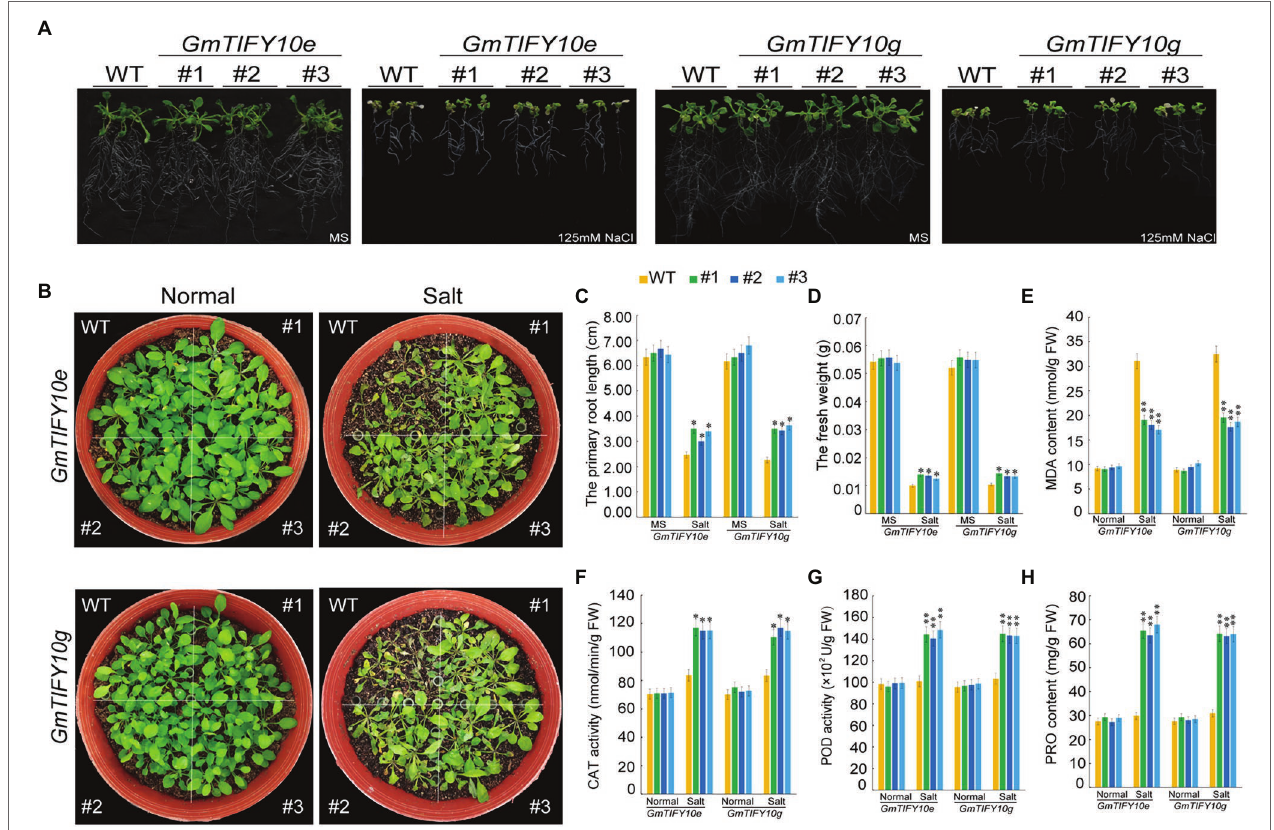
FIGURE 9 | Overexpression of GmTIFY10e and GmTIFY10g in Arabidopsis plants enhanced tolerance to salt stress. (A) Phenotypic analysis of transgenic Arabidopsis lines and WT lines under normal and 125 mM NaCl treatment. The scale bar indicates 2 cm. (B) Phenotypes of WT and transgenic plants under salt stress. (C) The primary root length analysis of the transgenic Arabidopsis lines and WT plants under normal and 125 mM NaCl treatment. (D) The fresh weights of transgenic Arabidopsis lines and WT lines under normal and 125 mM NaCl conditions. (E–H) The leaf contents of MDA (E) , CAT (F) , POD (G), and PRO (H) in WT and transgenic plants under normal and salt stress. The data are shown as the means ± SD obtained from three biological replicates. ANOVA test demonstrates significant differences compared with WT ( * p < 0.05, ** p <